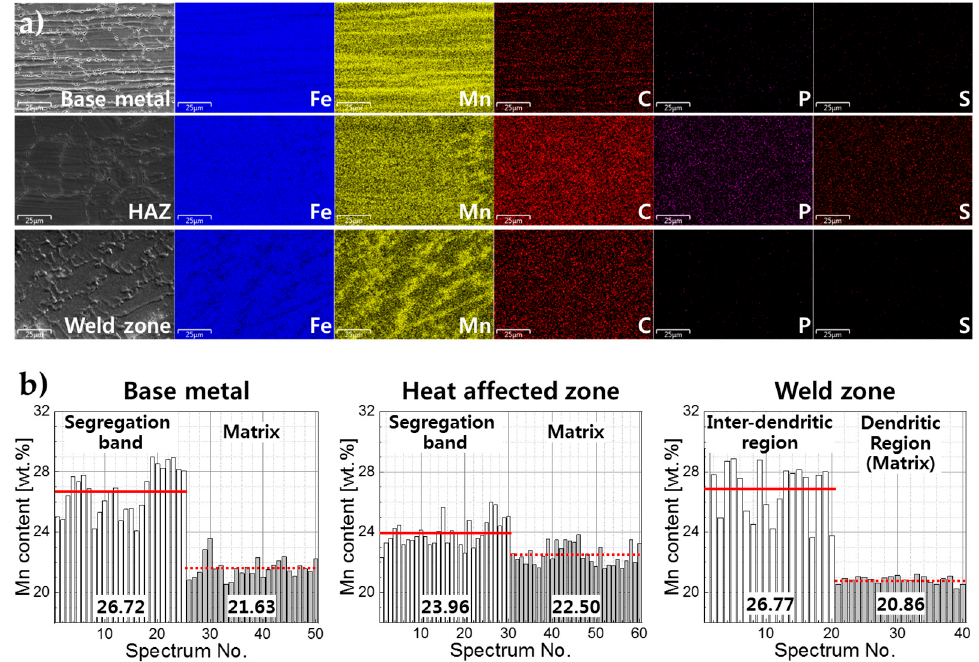
Figure 3. EDS analysis of base metal, heat affected zone (HAZ), and weld zone. ( a ) Image map analysis